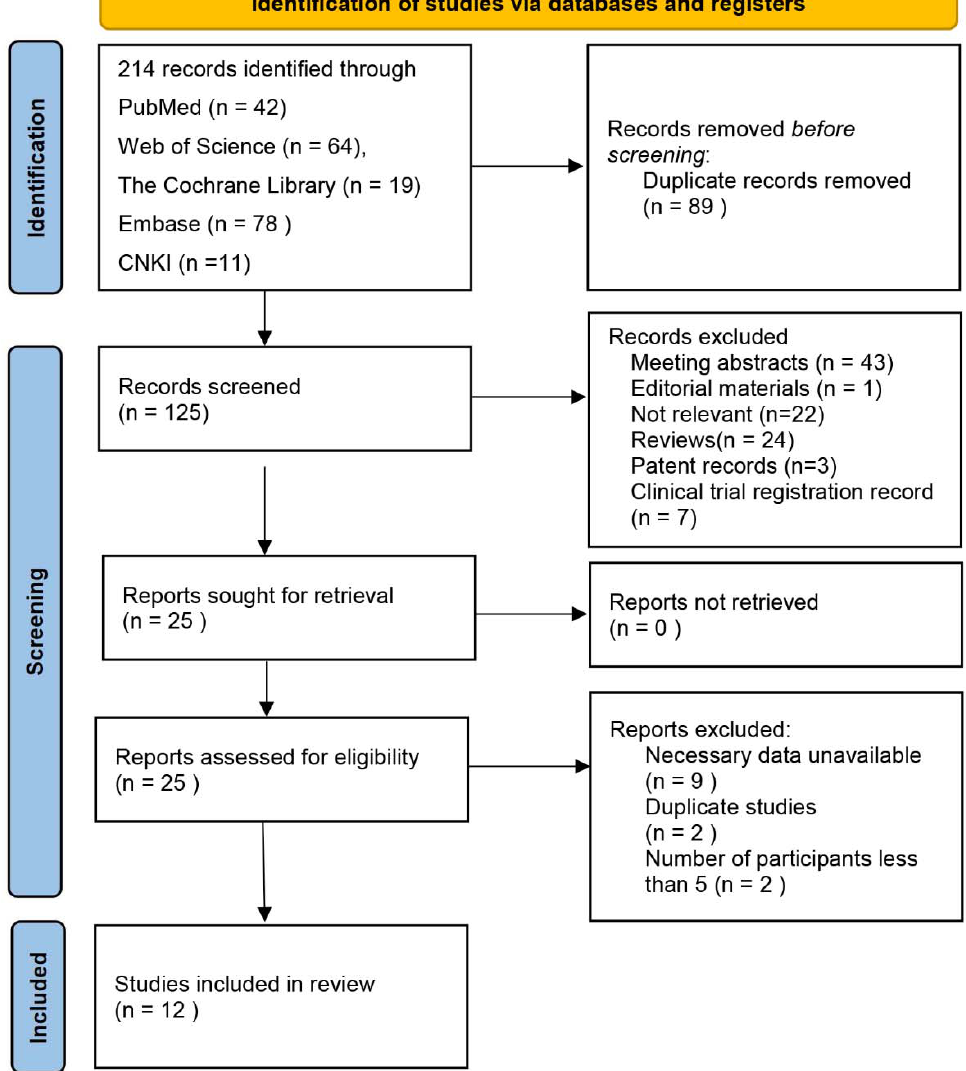
Figure 1. Flowchart of the studies selection process. CNKI: China national knowledge infrastructure.